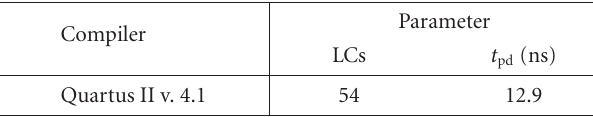
Table 5: Mapping of f k , N ( · ) for k = 7 and N = 27 into Altera STRATIX EP1S25-5